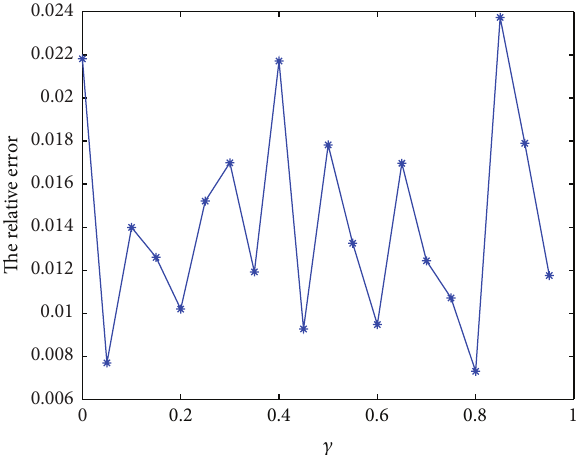
Figure 8: The relative error versus order 𝛾 for Example 3 with 𝑇 = = 1𝑒 − 10 for noise 𝜖 = 1 1 , 𝑚 = 100 , and 𝑡 0